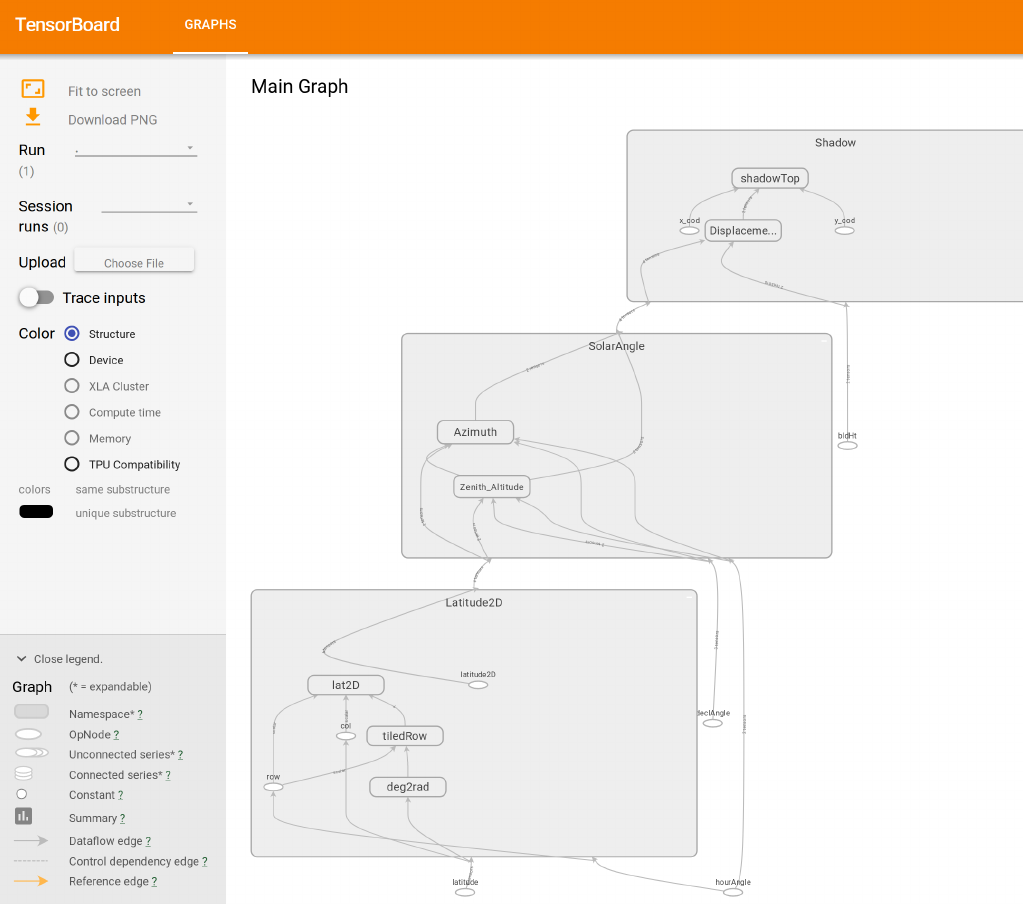
Figure 12. Dataflow Graph Generated by TensorBoard For Shadow Calculation Table 1. Input/ output of Solar Irradiation